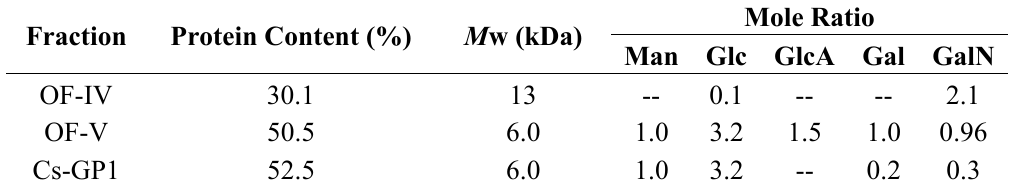
Table 1. Composition and molecular weight of EPS-2 fractions obtained by gel filtration